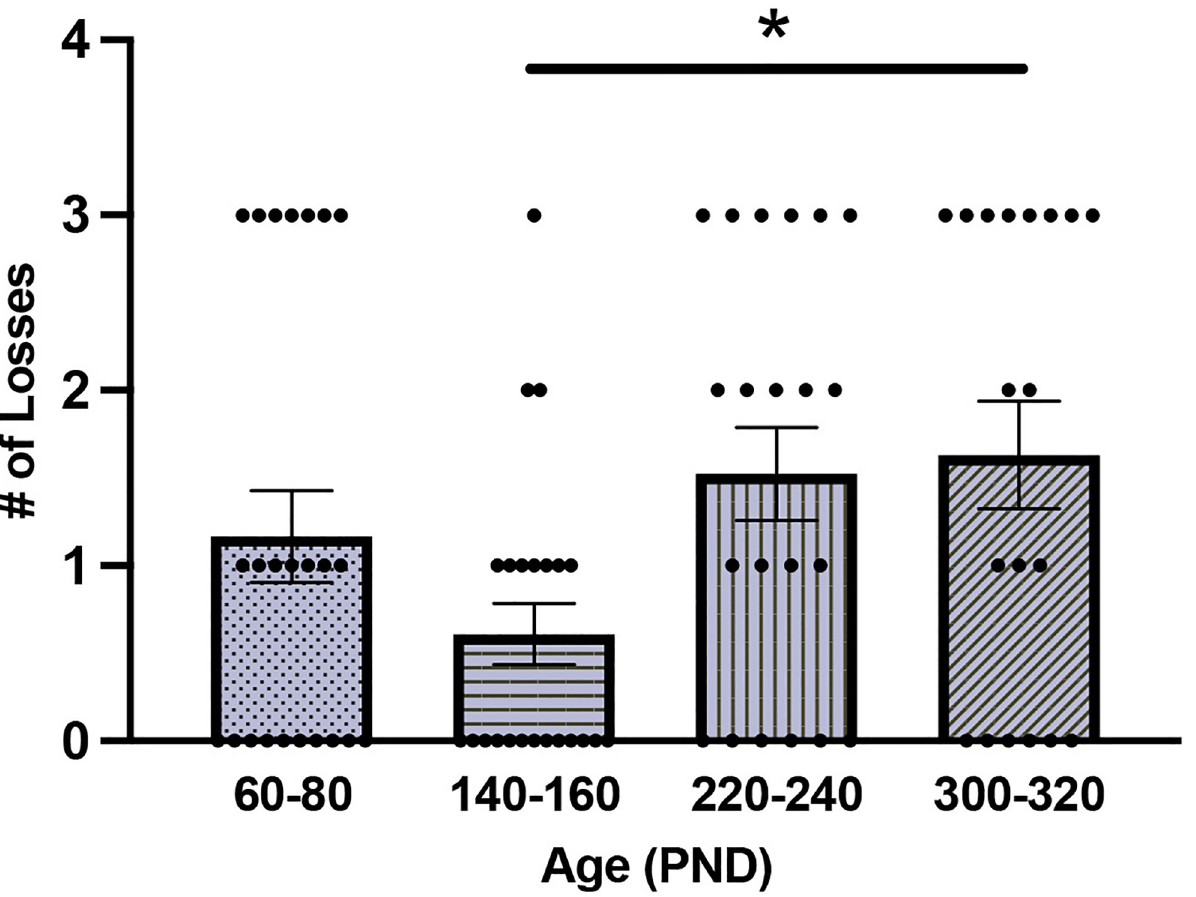
Fig 2. Mean ± SEM the number of losses in the dominance test for each age group. Voles between PND140-160 lost fewer trials compared to voles aged PND300-320. Dots represent individual data points. � indicate statistical significance.